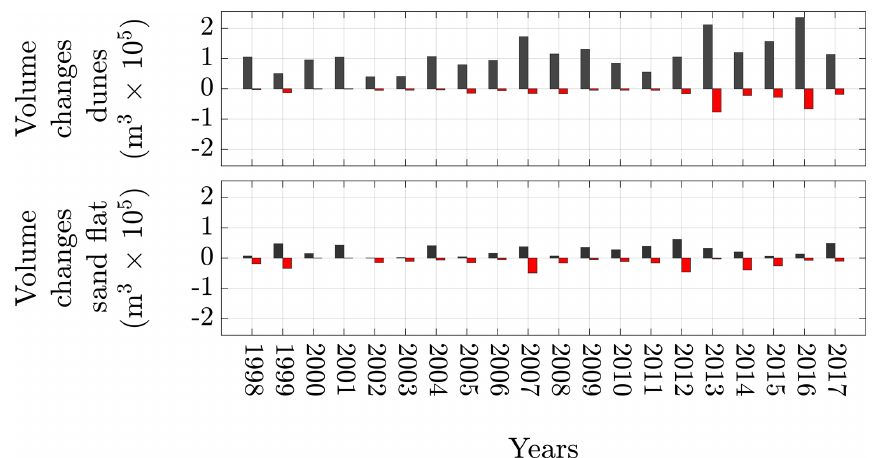
Figure 6. Annual volume changes for the sand flat and dune area considering only cells where elevation change was greater than 0.16m (approximately the maximum possible error based on the allowed error for each lidar survey. Black boxes represent accretion, whereas red boxes represent